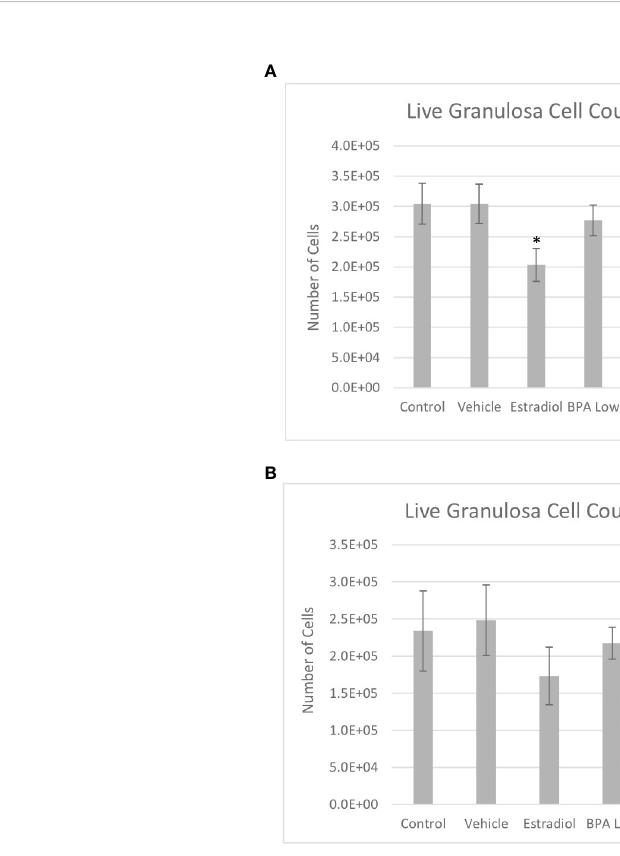
FIGURE 2 Live granulosa cell counts using the TC10 Automated Cell Counter. Cell counts were obtained following treatment with low dose (0.5 m g/mL) and high dose (50 m g/mL) BPA, BPS and BPF. (A) depicts the 12-hour timepoint and (B) displays the 48-hour timepoint. *p<0.05 compared to controls was considered statistically signi fi cant. Error bars represent +/-